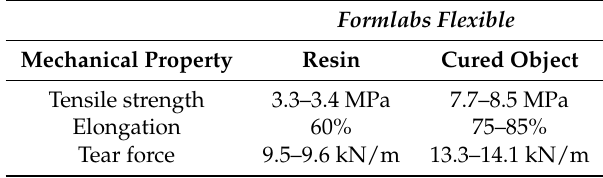
Table 1. Some of mechanical properties of Formlabs Flexible material